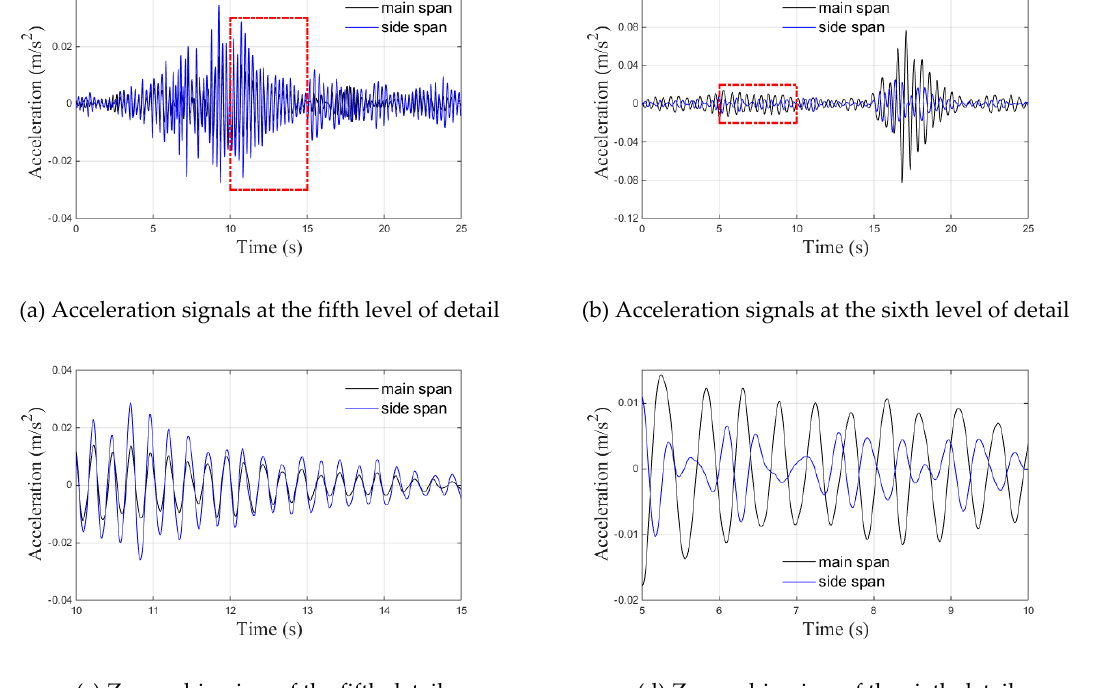
Figure 11. Details of the fifth and sixth decomposition levels regarding the vertical acceleration signals in Set 1: ( a ) vertical acceleration signal details at the fifth level; ( b ) vertical acceleration signal details at the fifth level; ( c ) zoomed-in view of the fifth detail; ( d ) zoomed-in view of the sixth detail.